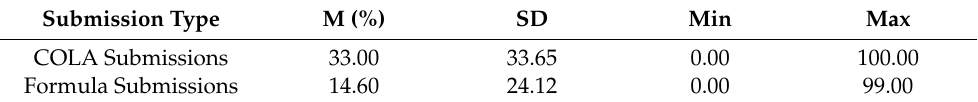
Table 6. Mean Resubmission Frequencies for COLA and Formula